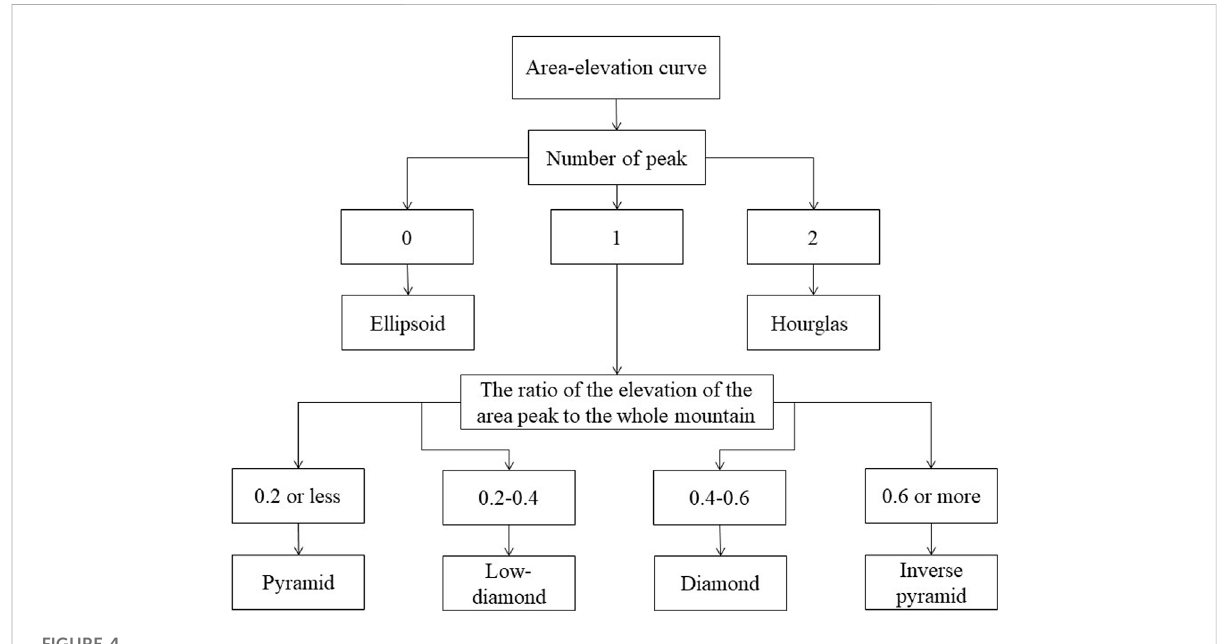
FIGURE 4 Algorithm for judging the mountain